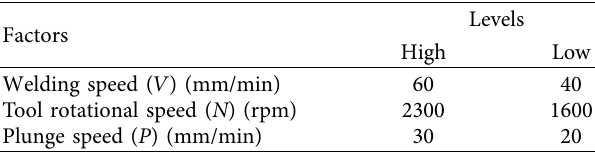
Figure 2: Photographic view of FSW arrangement and joining process. Table 4: Factors selected and their levels.